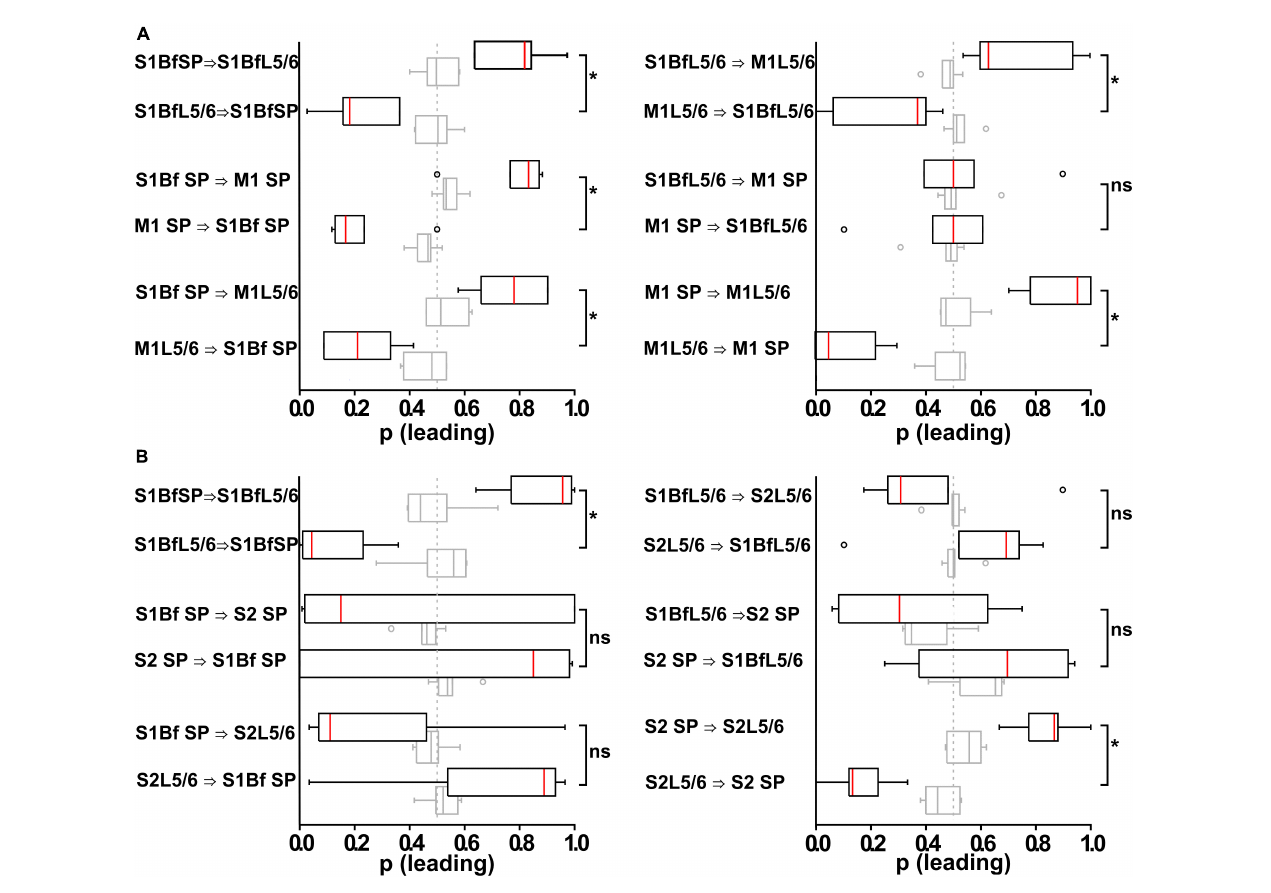
FIGURE6 Analysis of burst onset differences in bursting multi-unit activity (MUA) activity between and within different layers in S1Bf, S2, and M1. (A) Box plots representing the relative occurrence (as normalized to the total number of correlated burst within an electrode pair) of burst onset at a given electrode pair inserted in S1BF and M1. Open circles represent identified outliers, shaded box plots represent the results of surrogate data sets and the dashed gray line at 0.5 represents a random distribution of burst onsets. Significant differences of burst onset between electrode pairs are indicated. Note the high occurrence of spike onsets in S1Bf SP, suggesting that neurons from the SP projecting to other areas might have a higher relevance for initiating postsynaptic local network activity. (B) As panel (A) but for an electrode pair using an electrode pair inserted in S1BF and S2. Note the absence of a significantly directionality except for the SP to Layer 5/6 connections within both regions. * p < 0.05; ns, no significant